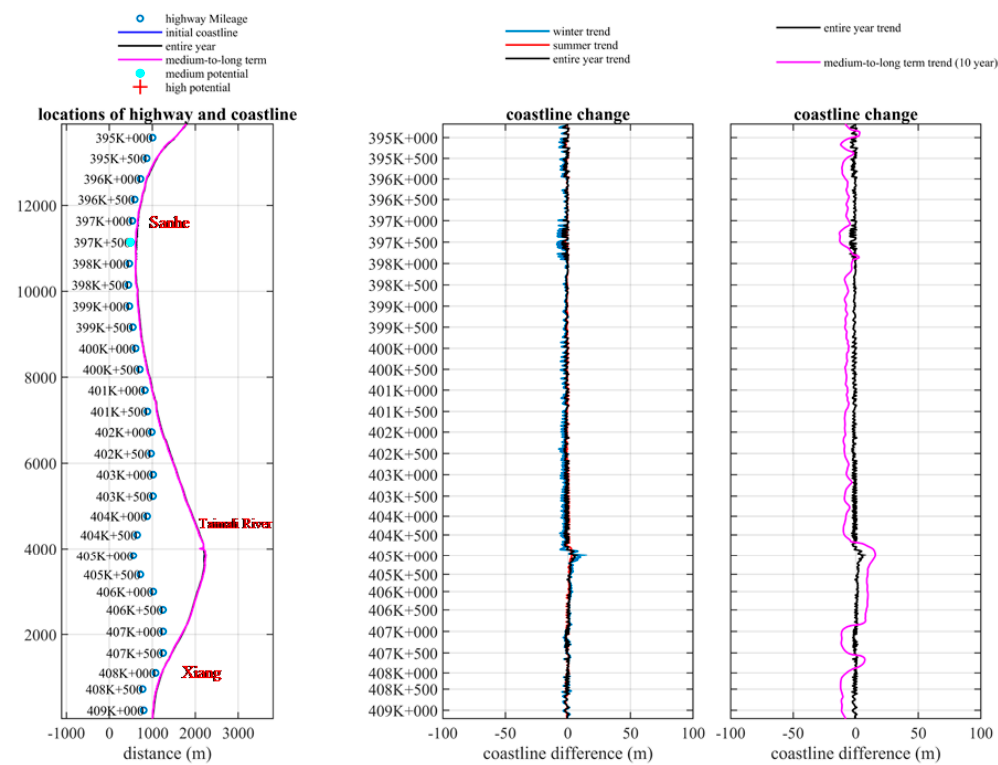
Figure 30. Map of the potential for erosion in Region